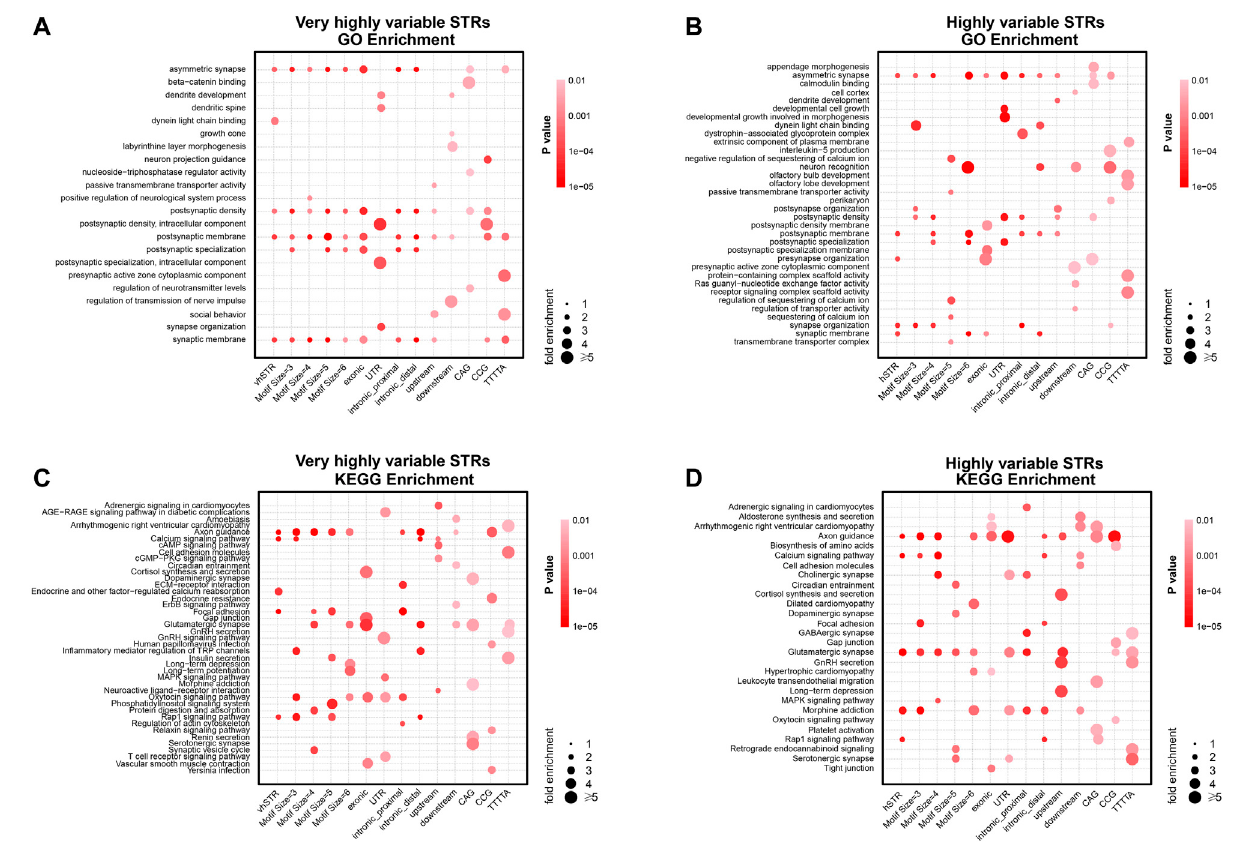
FIGURE 5 | Enrichment pathways of vhSTRs and hSTRs. (A) Signi fi cant GO terms of vhSTR. (B) Signi fi cant GO terms of hSTR. (C) Signi fi cant KEGG pathways of vhSTR. (D) Signi fi cantKEGGpathwaysofhSTR.vhSTRs=veryhighlyvariableSTRs,hSTRs=highlyvariableSTRs.GO=GeneOntology,KEGG=KyotoEncyclopedia of Genes and Genomes. In all panels, the rows represent the entire dataset of vhSTR or hSTR and their subset strati fi ed by different motif sizes, genomic regions, and eSTR repeat units. The columns represent the GO terms or KEGG pathway. Fisher ’ s exact test was used to calculate the p -value for each